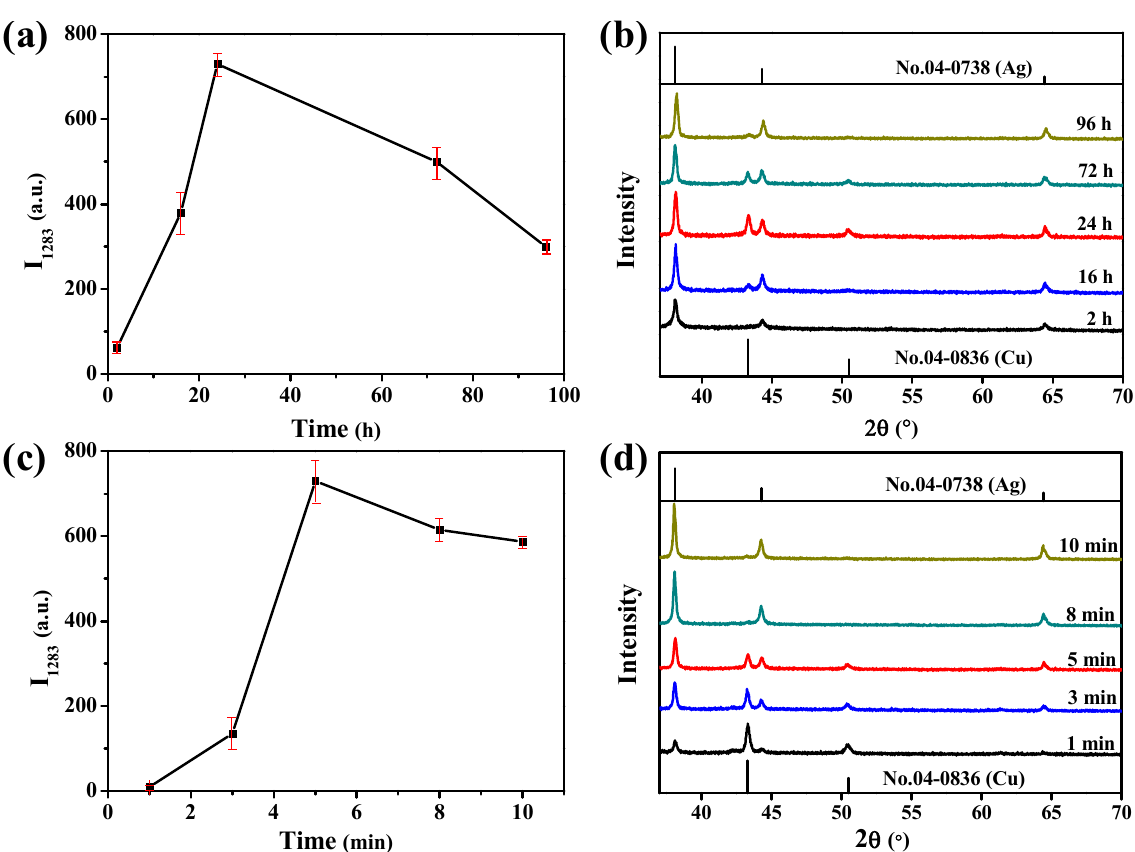
Figure 2. ( a , b ) Influence of the Cu deposition time on ( a ) the peak intensity of TBBPA at 1283 cm − 1 and ( b ) the XRD pattern of the Cu-Ag chips. The replacement time of Ag was set as 5 min. ( c , d ) Influence of the Ag replacement time on ( c ) the peak intensity of TBBPA at 1283 cm − 1 and ( d ) the XRD pattern of the Ag-Cu chips. The deposition time of Cu was set as 24 h.